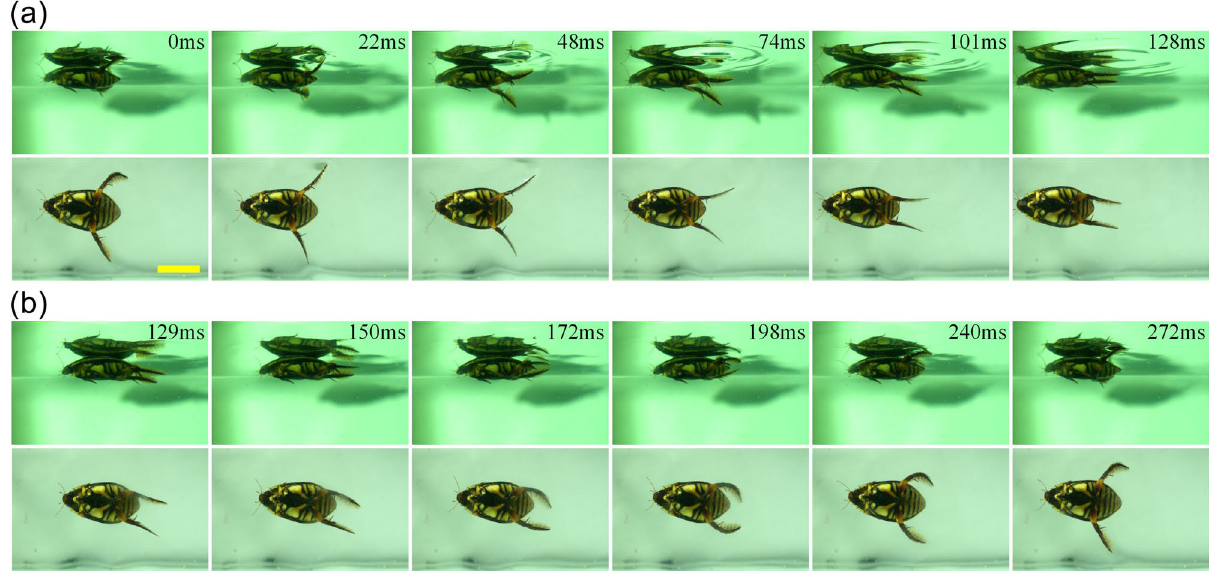
Figure 1. One forwarding cycle of a diving beetle: the period of motion is 272 ms, and includes (a) the power stroke and (b) the recovery stroke, the power stroke accounts for about 47% of the entire cycle, the scale bar = 20